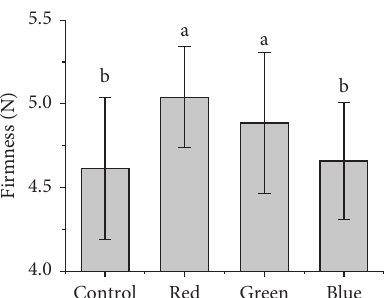
Figure 3: Effect of light exposures on firmness of the fresh-cut watermelon. Data are mean ± standard deviation ( n ≥ 3). Means with different letter represent a significant difference ( P < 0 .